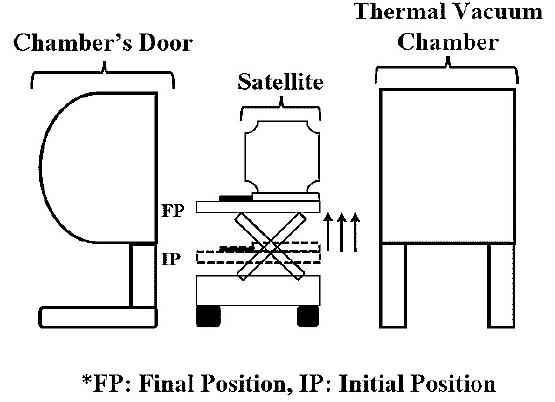
Figure 1. Scissor mechanism platform